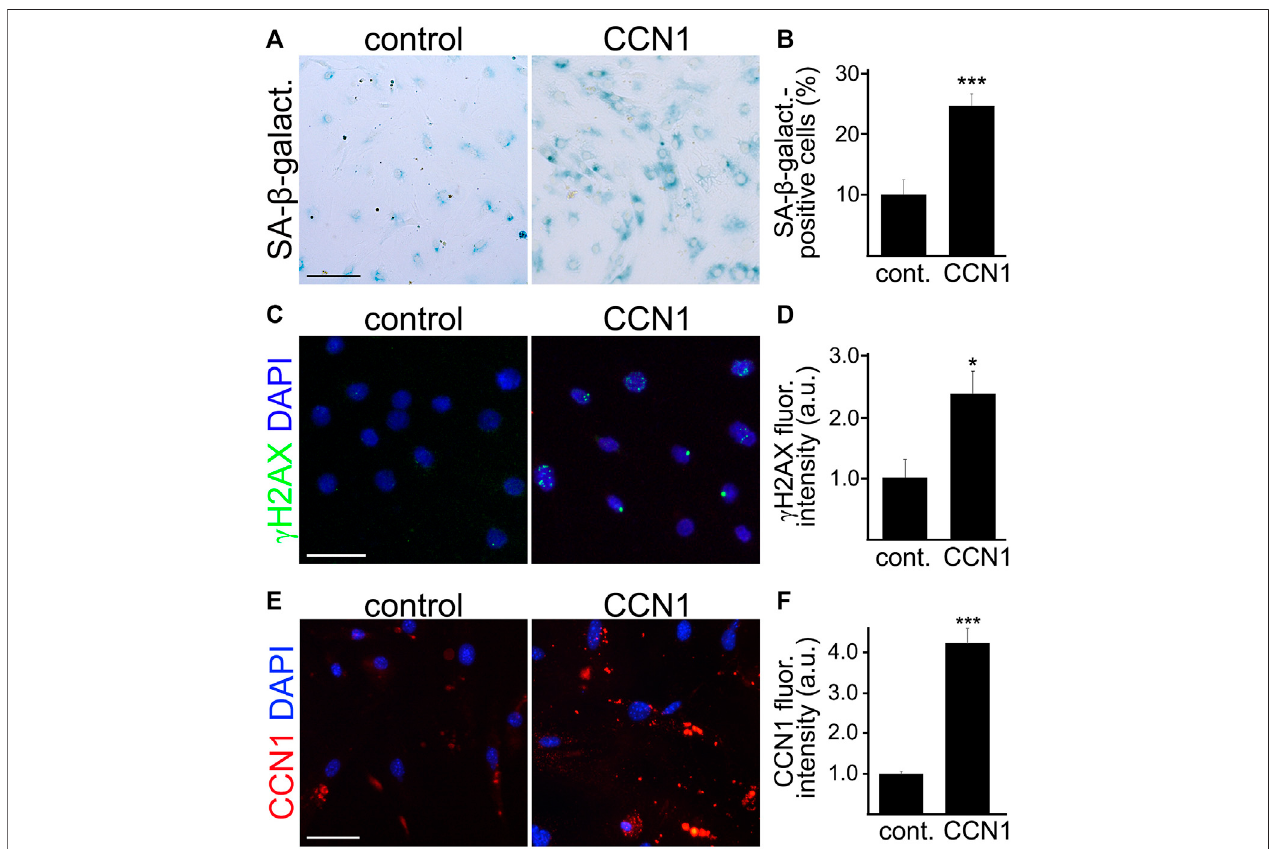
FIGURE 5 | CCN1 induced senescence-associated phenotypes in cultured CEC. CEC were isolated from aged (18 – 20 m/o) female mice and cultured. Cultured CEC were stained with SA- β -galactosidase staining kit (A) , or with antibodies against the double-strand DNA damage marker γ H2AX (C) , or with antibodies against CCN1 (E) , and with the nuclear Hoechst dye (C , E) . The percentage of SA- β -galactosidase-positive cells (B) , the fl uorescence intensity of γ H2AX (D) , and the fl uorescenceintensityofCCN1 (F) werequanti fi ed.Scalebar (A) ,100 μ m;scalebar (C) ,50 μ m;scalebar (E) ,50 μ m. t -test,*** p -value (B) (cid:2) 0.0001, n (cid:2) 4;* p -value (D) (cid:2) 0.0164, *** p -value (F) (cid:2) 0.0001. Data were pooled from three independent experiments analyzing 20 microscopic fi elds (A , B , E , F) or 50 cells (C , D) per condition and